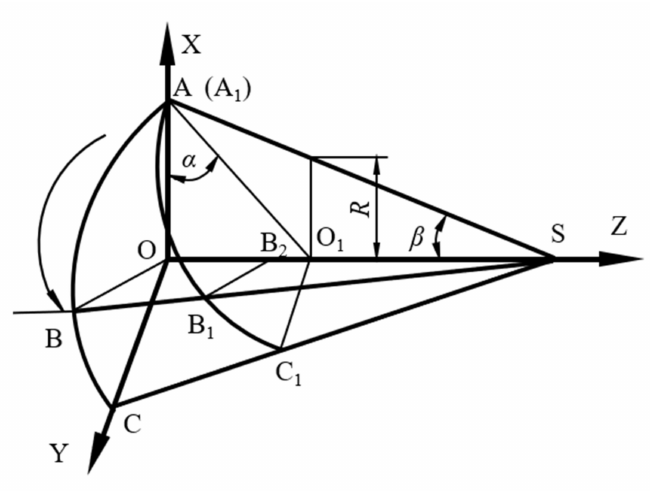
Figure 4. The trajectory of the